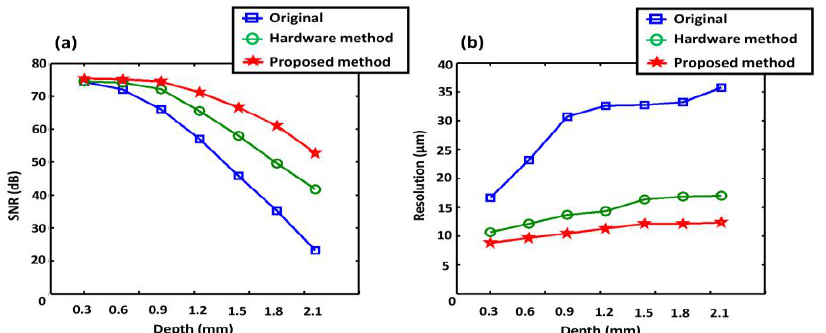
Figure 4. ( a ) SNR comparison between non-linearized k -domain, linearized k -domain using conventional technique, and linearized k -domain using proposed technique. ( b ) Comparison between quantitative representations of axial resolutions obtained in the above three